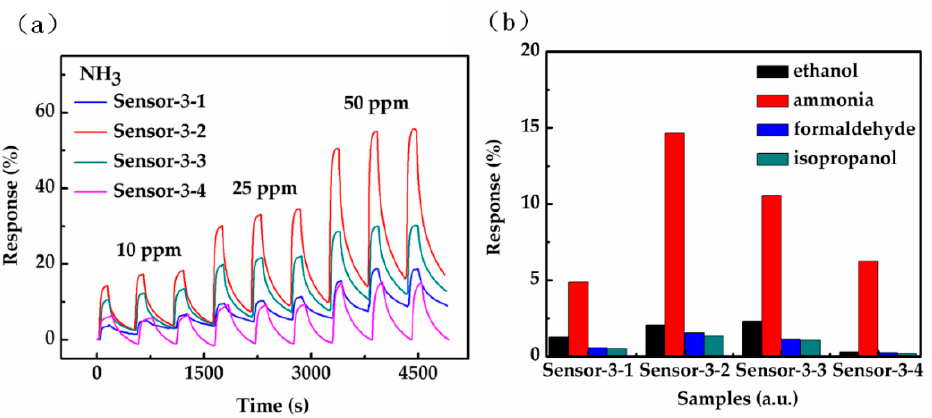
Figure 9. ( a ) Profile of four RGO-Gr hybrids gas sensors after three continuous cycles under three different concentrations of ammonia; ( b ) selectivity response when exposed to ethanol, formaldehyde, isopropanol and ammonia at 10 ppm.